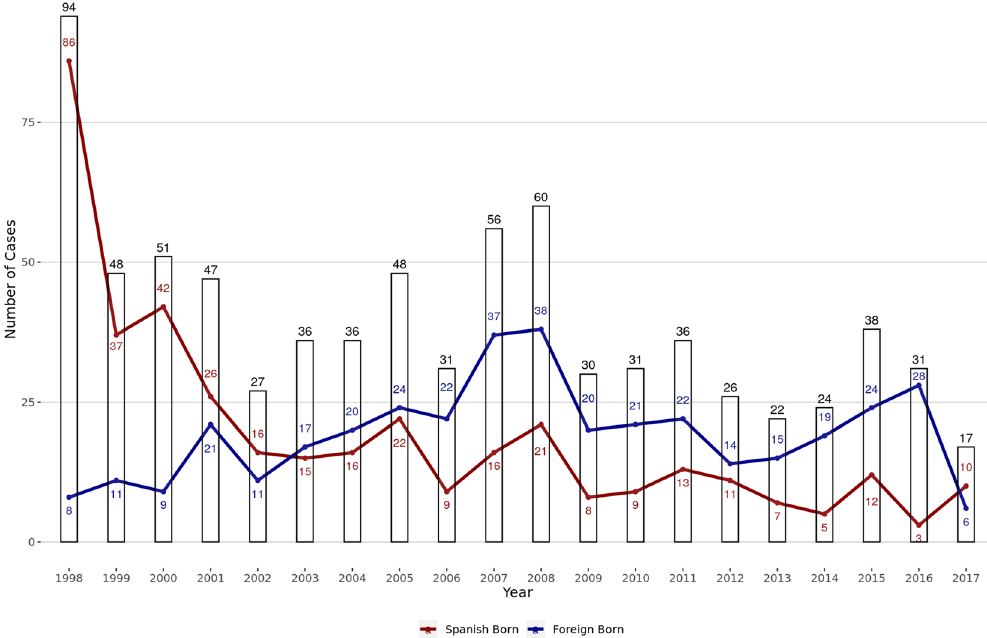
Figure 2. Distribution based on the origin of the cases along the 20 years of the study. The red line represents the native-born cases, blue line shows foreign-born cases and the bars represent the total number of